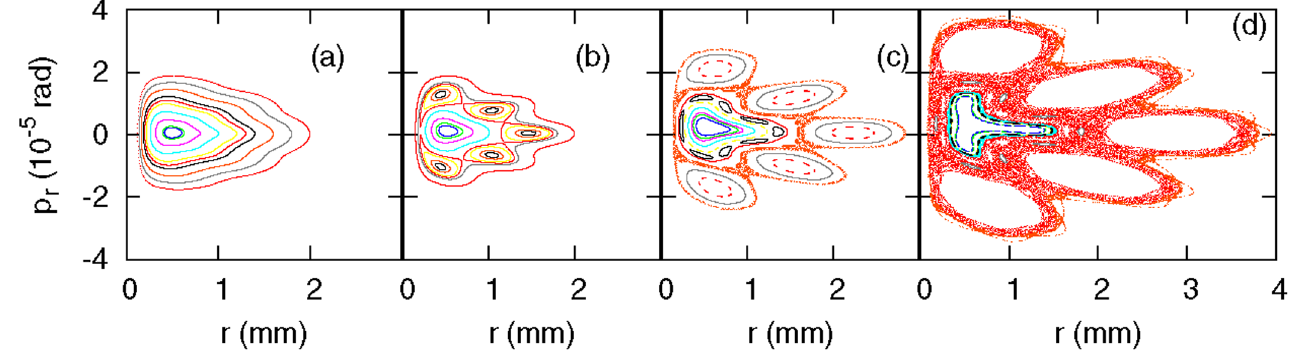
FIG. 3. (Color) Poincare´ plot in r (cid:1) p space for various tune shift values: (a) (cid:12) (cid:5) 0 : 06 , (b) (cid:12) (cid:5) 0 : 13 , (c) (cid:12) (cid:5) 0 : 27 , and (d) (cid:12) (cid:5) 0 : 38 r